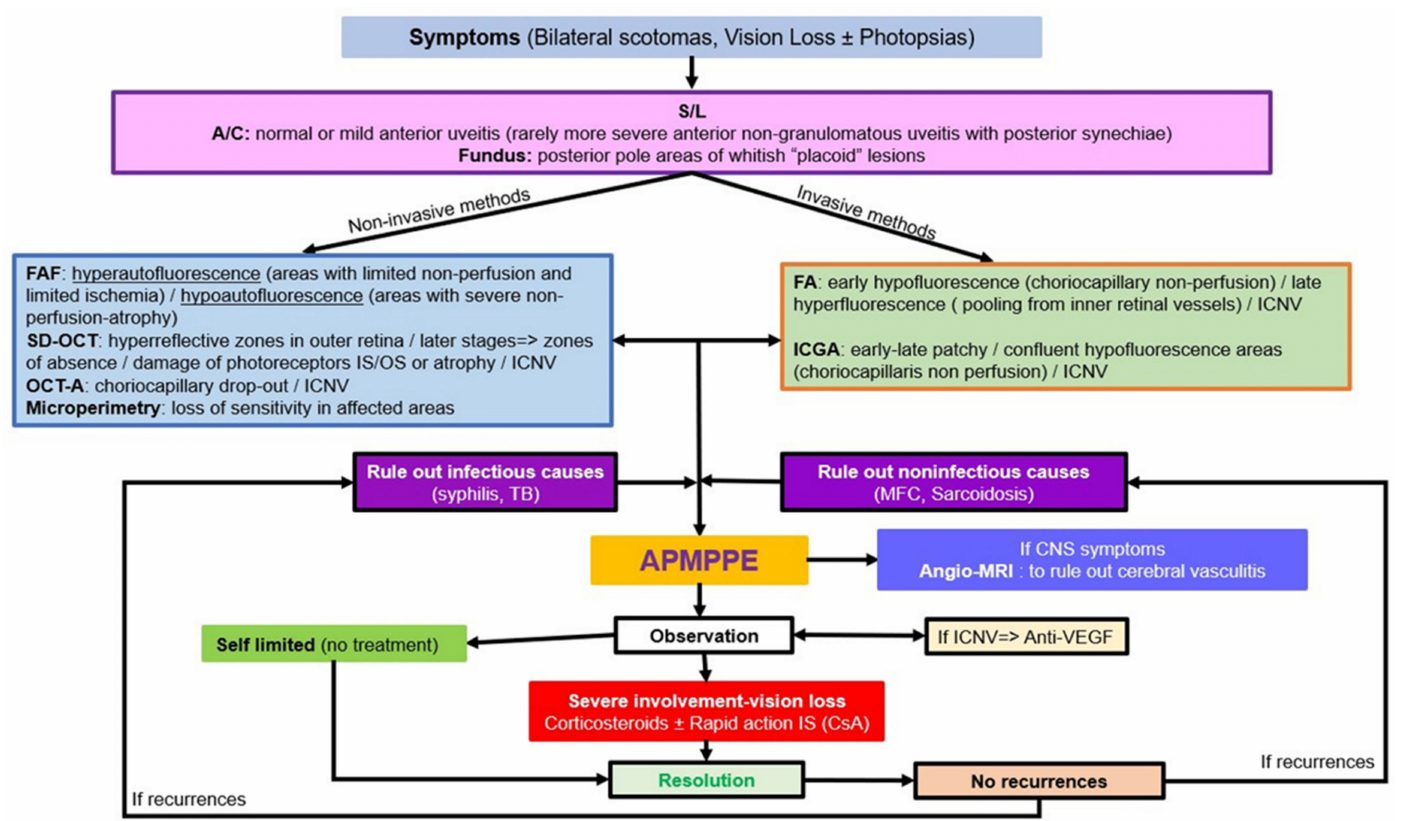
Scheme 2. Appraisal of APMPPE/AMIC: decision tree in clinical practice. S/L: slit lamp. A/C: anterior chamber. FAF: autofluorescence. SD-OCT: spectral domain optical coherence tomography. OCT-A: OCT-angiography. VF: visual fields. FA: fluoresceine angiography. ICGA: indocyanine green angiography. TB: tuberculosis. MFC: multifocal. APMPPE: acute posterior multifocal posterior placoid epitheliopathy. CNS: central neural system. Anti-VEGF: anti-vascular endothelial growth factor. ICNV: inflammatory choroidal neovascularization. IS: immunosuppressors. CsA: